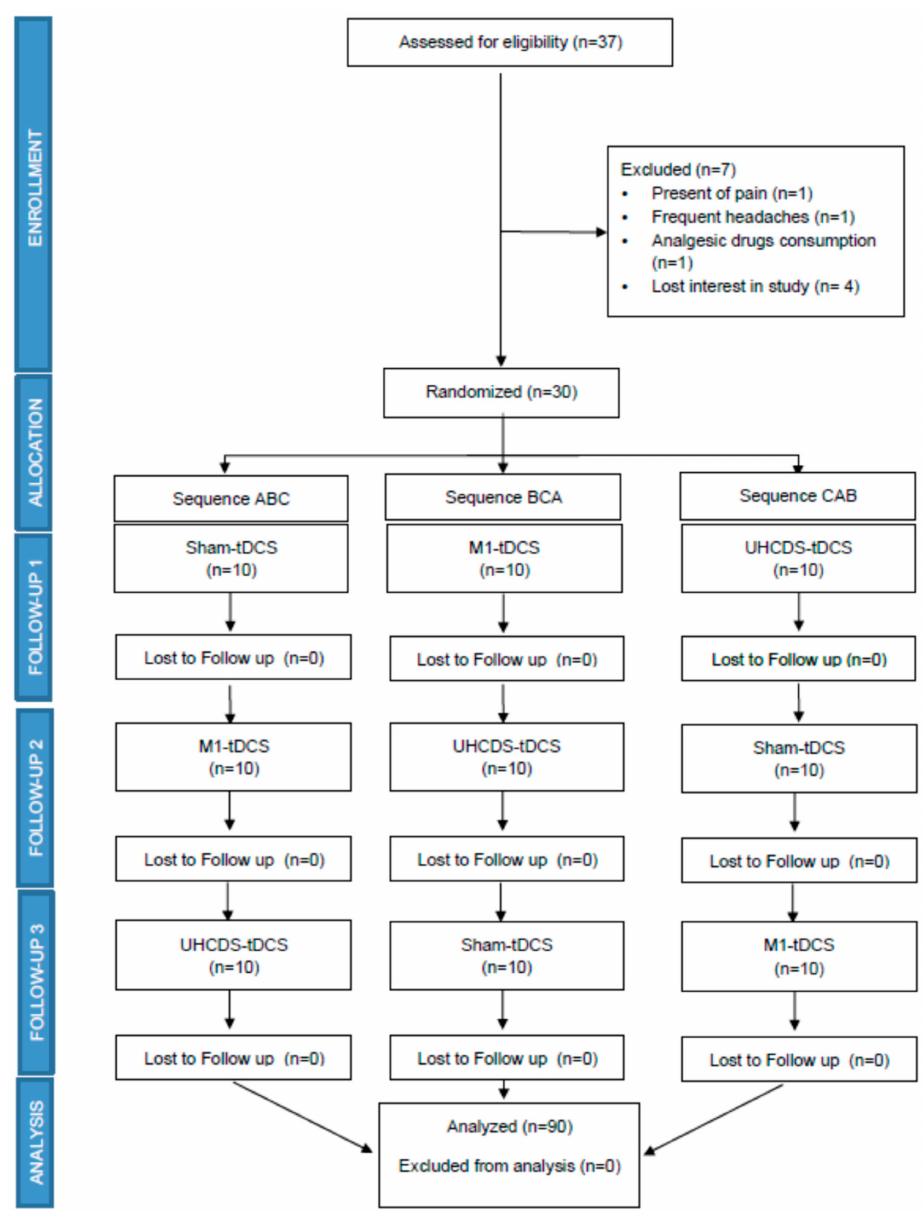
Figure 1. Consort flow diagram. tDCS: Transcranial direct current stimulation; UHCDS-tDCS: unihemispheric concurrent dual-site-Transcranial direct current